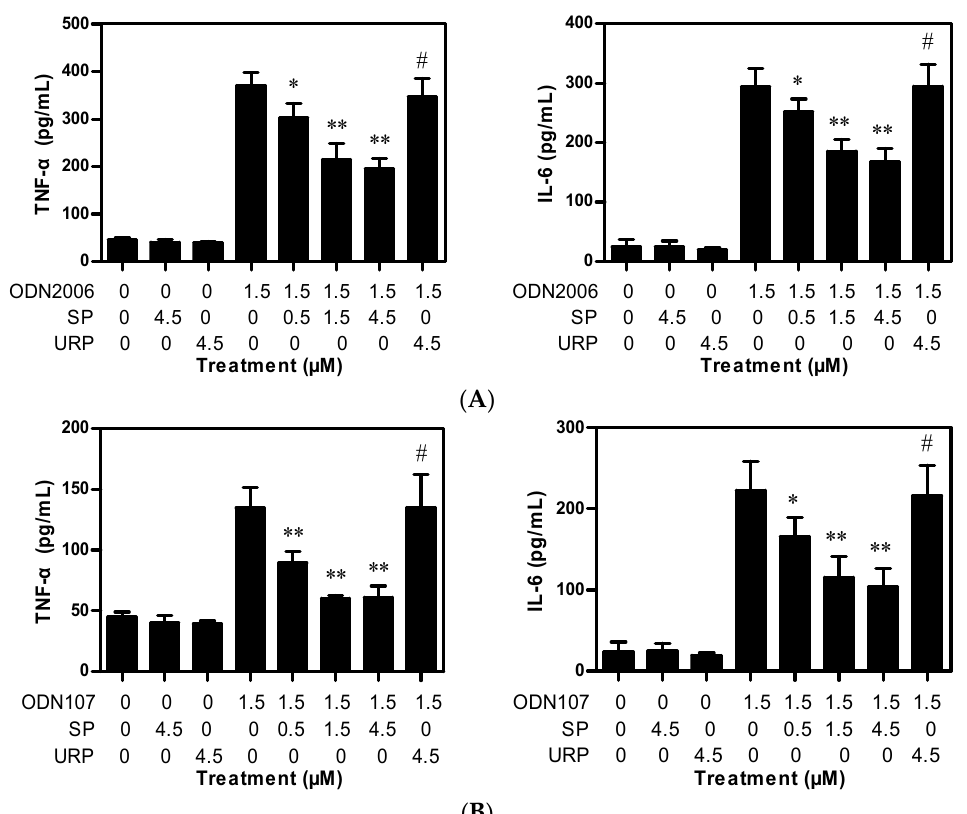
Figure 1. Synthetic peptide (SP) decreased TNF- α and IL-6 release from RAW264.7 cells treated with CpG oligodeoxynucleotides (CpG ODN). RAW264.7 cells (4.0 × 10 5 cells) grown in 48-well plates were treated with 1.5 μ M of ODN2006 or ODN107 preincubated with SP (0, 0.5, 1.5, or 4.5 μ M) or unrelated peptide (URP) (4.5 μ M) at 37 °C for 15 min. After incubation for 6 h, the supernatants were collected to detect TNF- α ( A ) and IL-6 ( B ) using enzyme-linked immunosorbent assay (ELISA) kits. Data from one of three independent experiments are shown ( n = 4). “ * ”, p < 0.05 vs. ODN2006 or ODN107; “ ** ”, p < 0.01 vs. ODN2006 or ODN107; “#”, p > 0.05 vs. ODN2006 or ODN107.